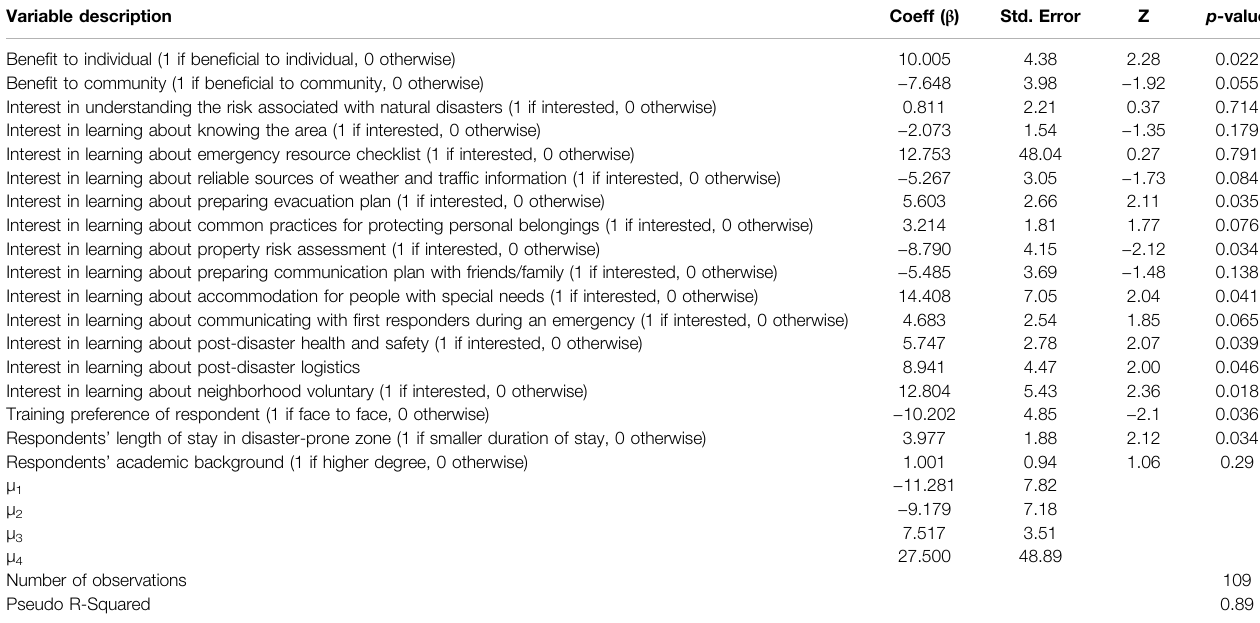
TABLE 3 | Coef fi cients and p -value from ordered probit analysis for expected need of disaster preparedness training. Variable description Coeff ( β ) Std. Error Z p